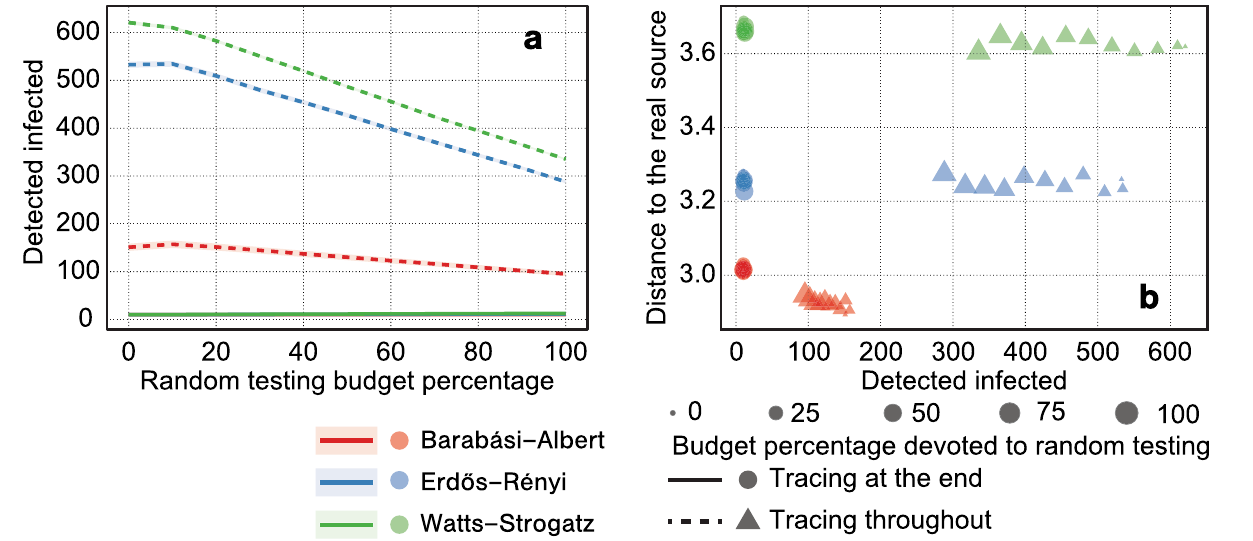
Figure 6. The effectiveness of tracing when ran during the infection process. Panel a presents the number of detected infected nodes based on the percentage of the budget devoted to random testing. Panel b presents the number of detected infected nodes and the distance to the real source in settings with varying percentages of the budget devoted to random testing (represented by point size). The results are presented as an average of over 1000 simulations for networks with 100,000 nodes, with a new network generated for every simulation using either Barabási–Albert, Erdős–Rényi, or Watts–Strogatz model, with tracing budget b = 100 in each round. Colored areas represent 95% confidence